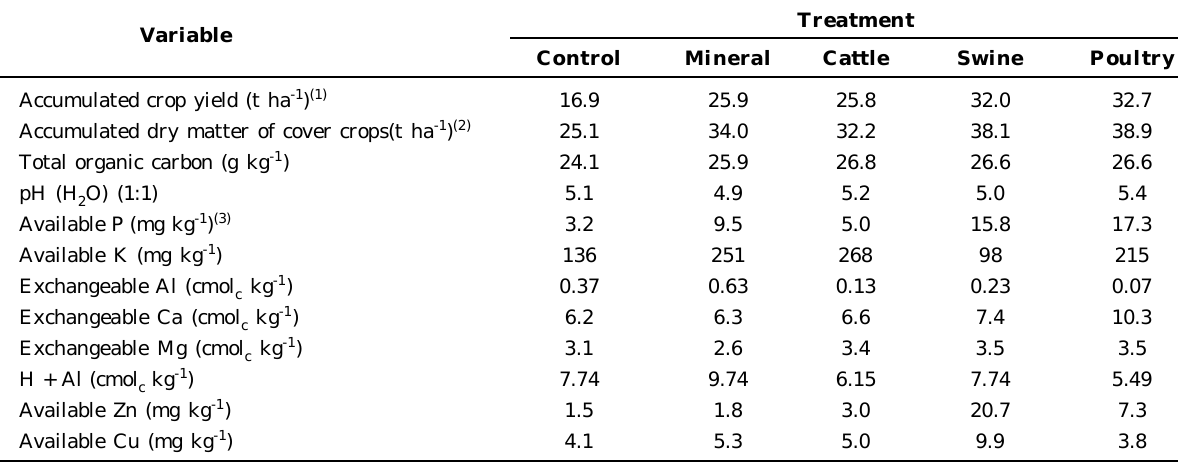
Table 1. Accumulated crop yield and soil characteristics after nine years of cultivation on no tillage soil with application of mineral fertilizer and different kinds of organic